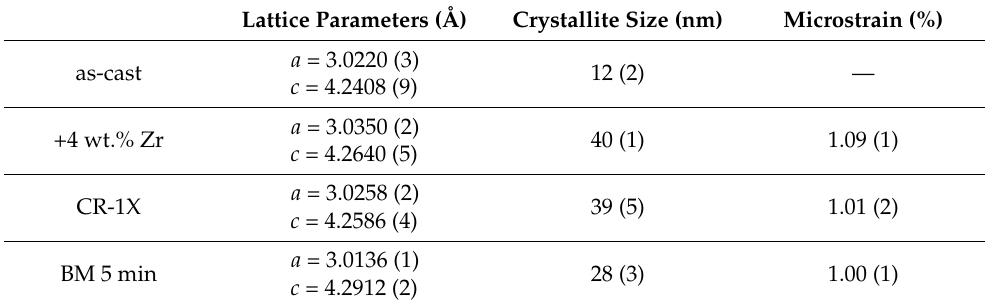
Table 3. Crystal parameters of Ti 16 V 60 Cr 24 alloys after